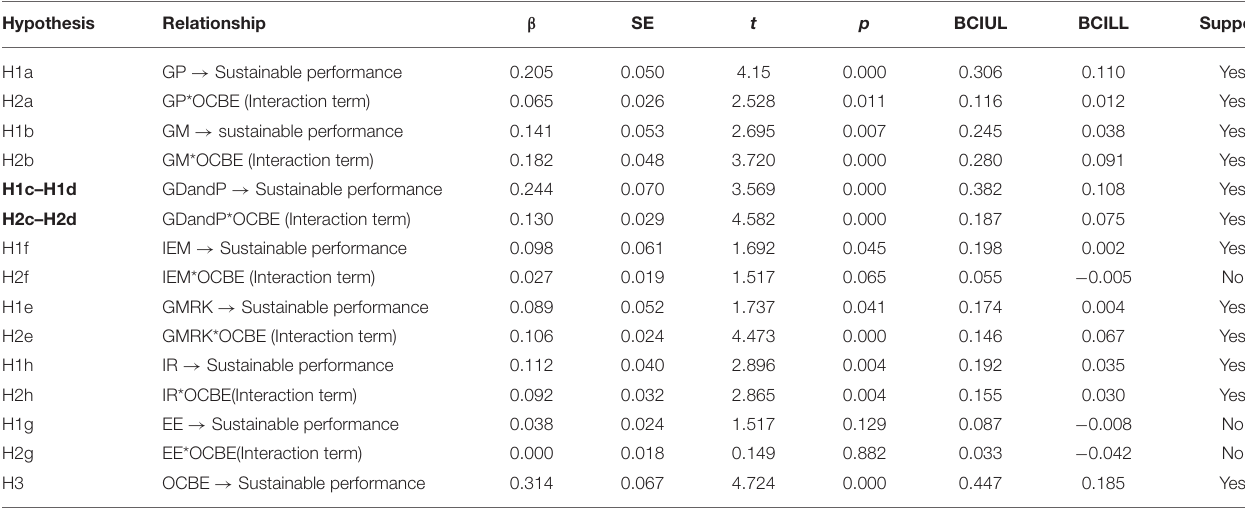
TABLE 3 | Hypotheses testing moderation